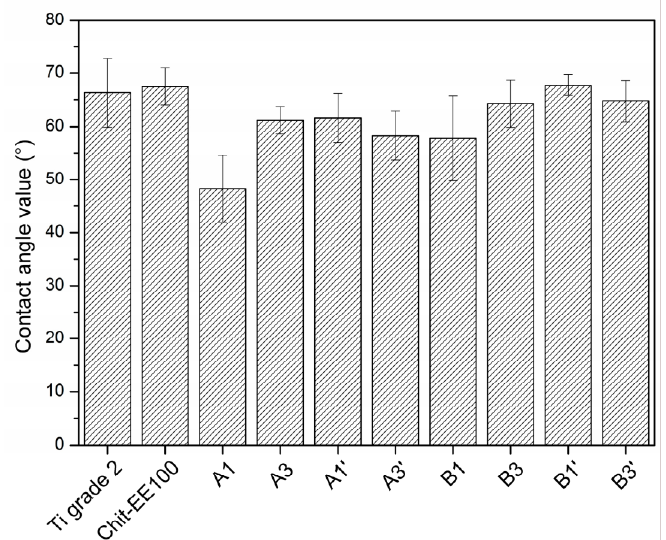
Figure 6. The results of water contact angle measurements for the bare titanium substrate, the chit/EE100 coating, and the chit/EE100/AgNPs coatings prepared with different process parameters; data are presented as the mean ± SD ( n = 6).